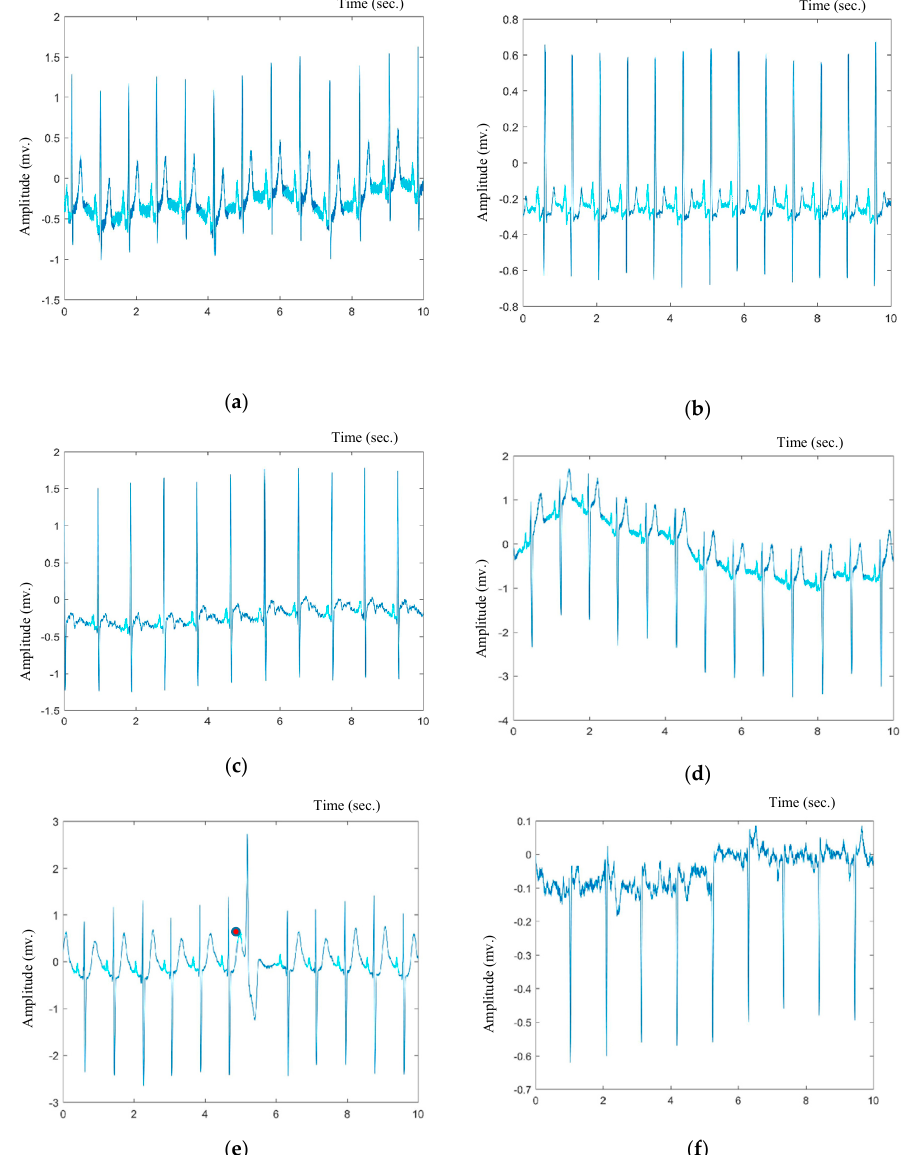
Figure 5. Demonstrating the performance of the proposed P-wave detection algorithm on the MIT-BIH atrial fibrillation database. The P-wave is detected in electrocardiogram (ECG) signals that contain: ( a ) high-frequency noise; ( b ) normal sinus rhythm without U-waves; ( c ) normal sinus rhythm with U-waves; ( d ) normal sinus rhythm with negative polarization; ( e ) merged P- and T-waves. Here, the red circle asterisk represents detection of merged P- and T-waves. ( f ) No P-wave detected in case of premature atrial